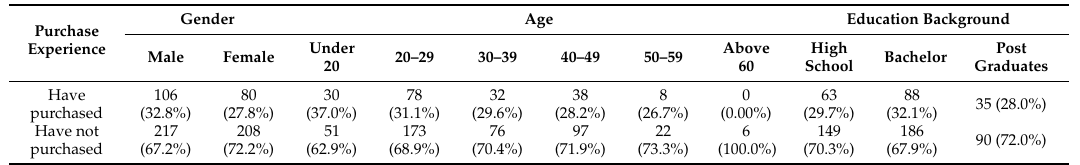
Table 3. Purchase experience of residents for remanufactured products.